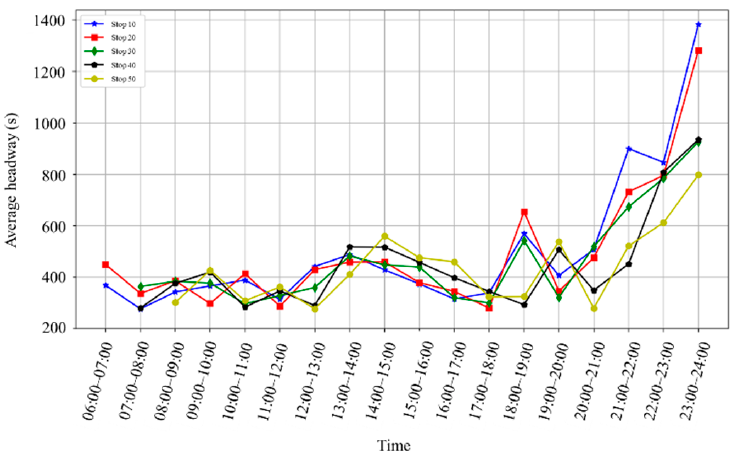
Figure 5. Daily variation of bus headway.